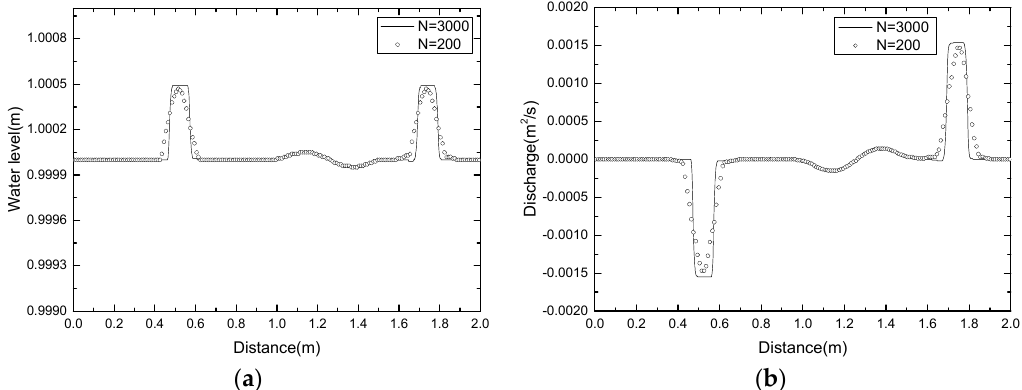
Figure 17. Small perturbation test with ε = 0.001 (small pulse) and time t = 0.2 s: ( a ) the water level; ( b ) the discharge.